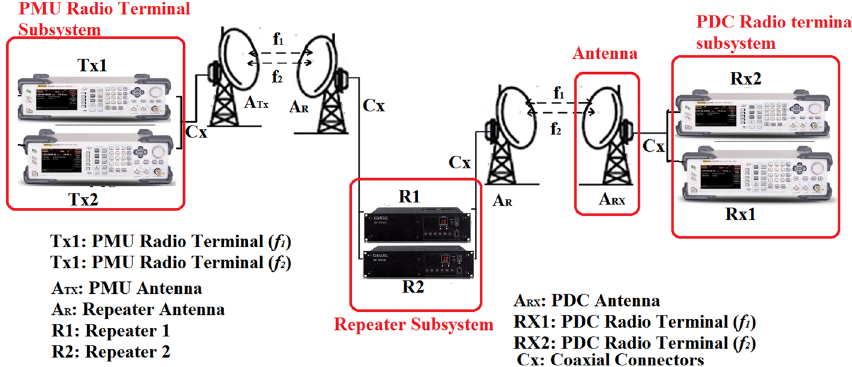
Fig. 3 A single repeater PMU MCS